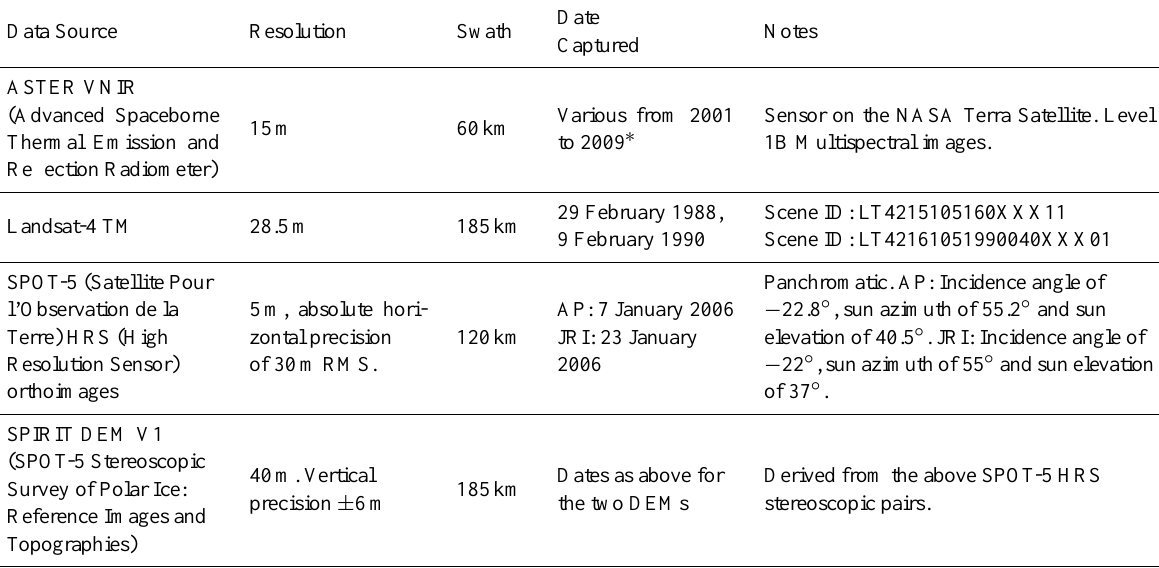
∗ Refer to Supplementary Methods for further details of ASTER